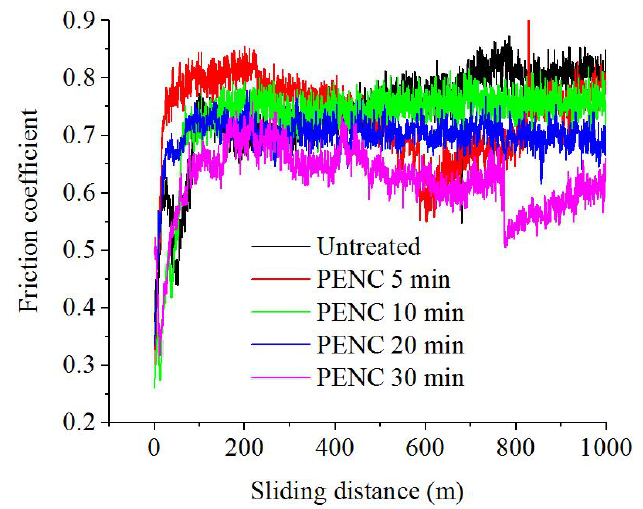
Figure 8. The dependence of the friction coefficient on the sliding distance of the untreated and PENC samples.